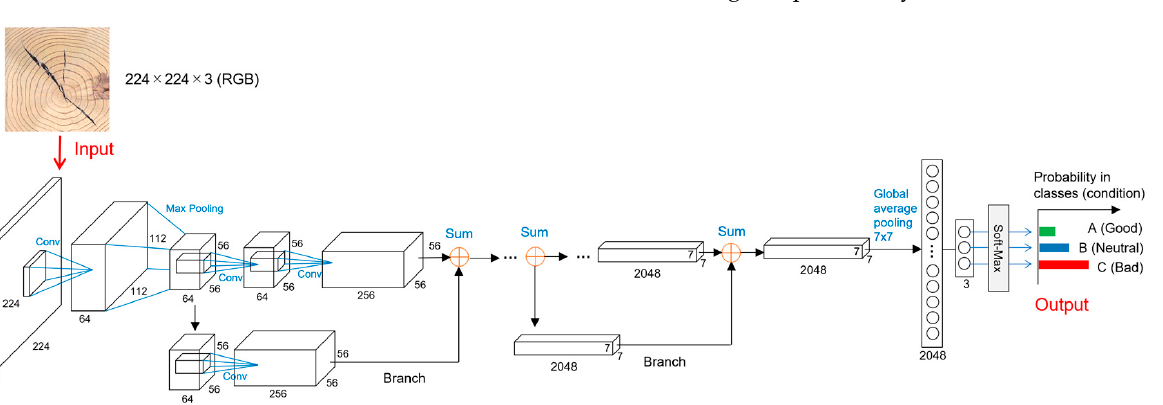
Figure 6. Image examples with classes depending on crack severity. ( a ) “Good” images classified in class A; ( b ) “Neutral” images with practically no significant cracks were classified into class B; ( c ) “Bad” images have noticeable cracking with risk to strength classified into class C.